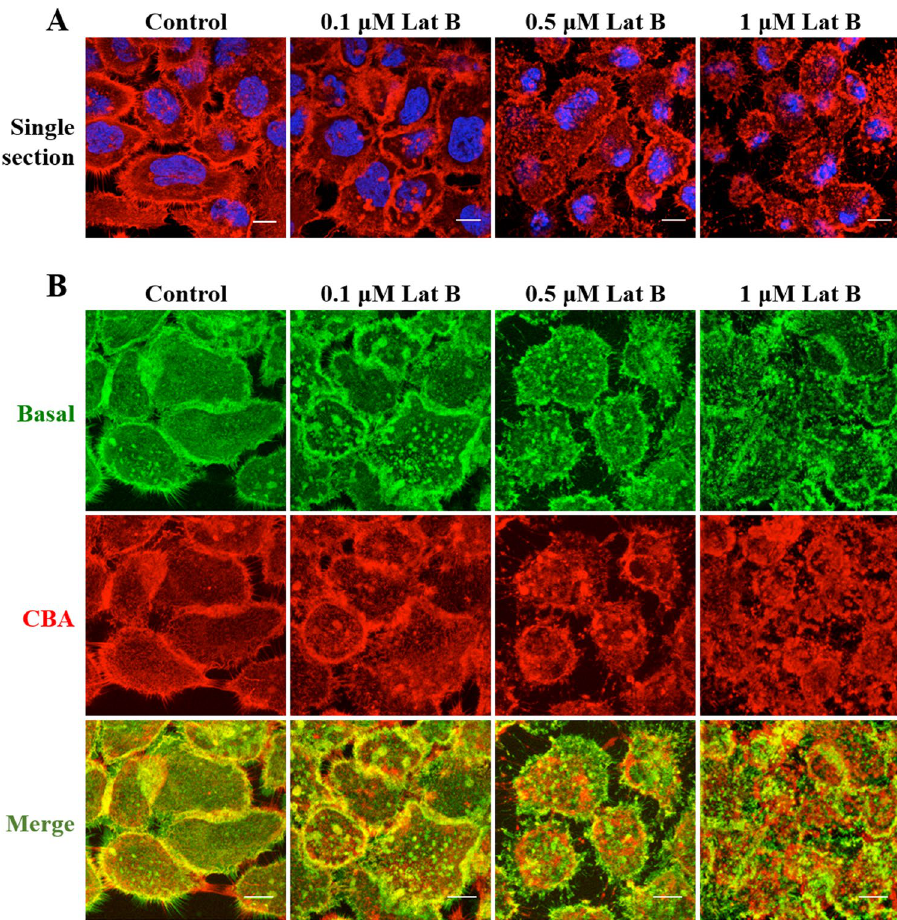
Figure 3. Effects of Lat B on the actin architecture in A431 cells. Cells on coverslips were treated either with diluent control (0.1% DMSO) or 0.1–1.0 μ M Lat B for 30 min before fixing and staining with Rh-P and Hoechst. Single sections ( A ) show the overall distribution of the actin relative to the nucleus. ( B ) Actin arrangement from the basal, CBA regions and composite (Merge) of basal and CBA. Scale bars 10 μ